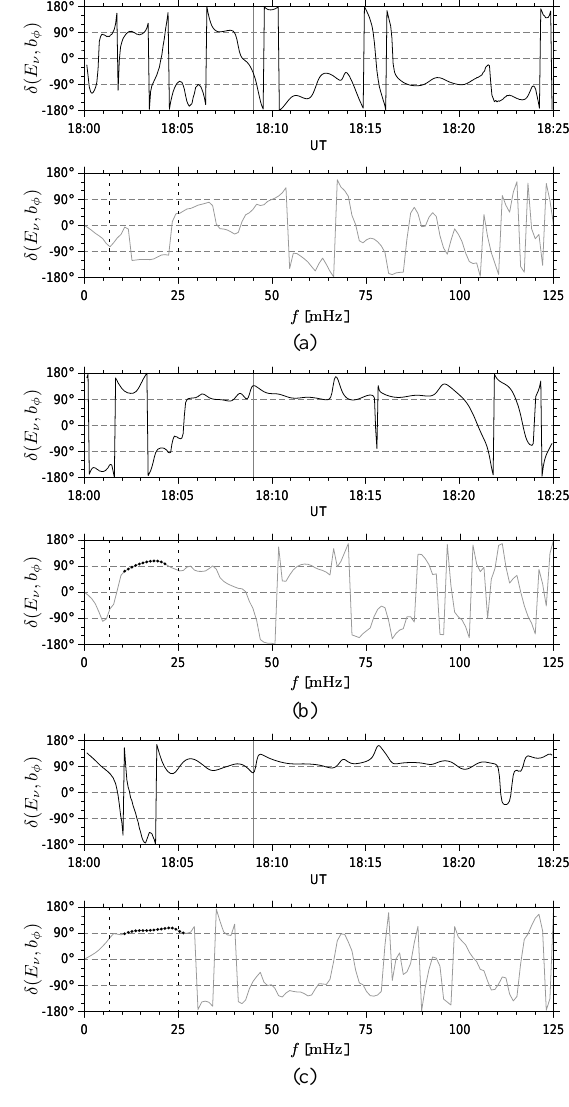
Fig. 8: Phase difference between E φ and b ν at (a) C1, (b) Fig. 8. Phase difference between E φ and b ν at (a) C1, (b) C2 and C2 and (c) C4. Solid points are only plotted at frequencies (c) C4. Solid points are only plotted at frequencies for which γ for which γ exceeds the threshold of 75%. exceeds the threshold of 75%.